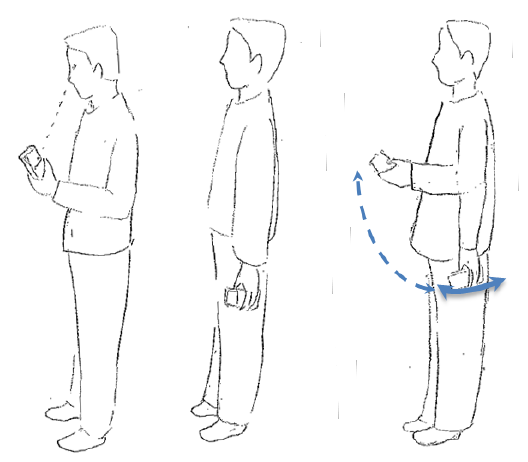
Figure 1. S-series (left and middle: ST, right: SS).